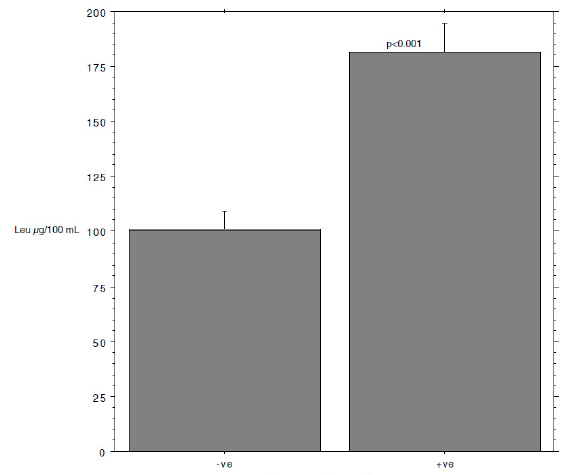
Figure 6. Bar plot for isoleucine content (mean and standard error) and ANOVA/Tukey-Kramer test comparing S . aureus positive and negative samples.